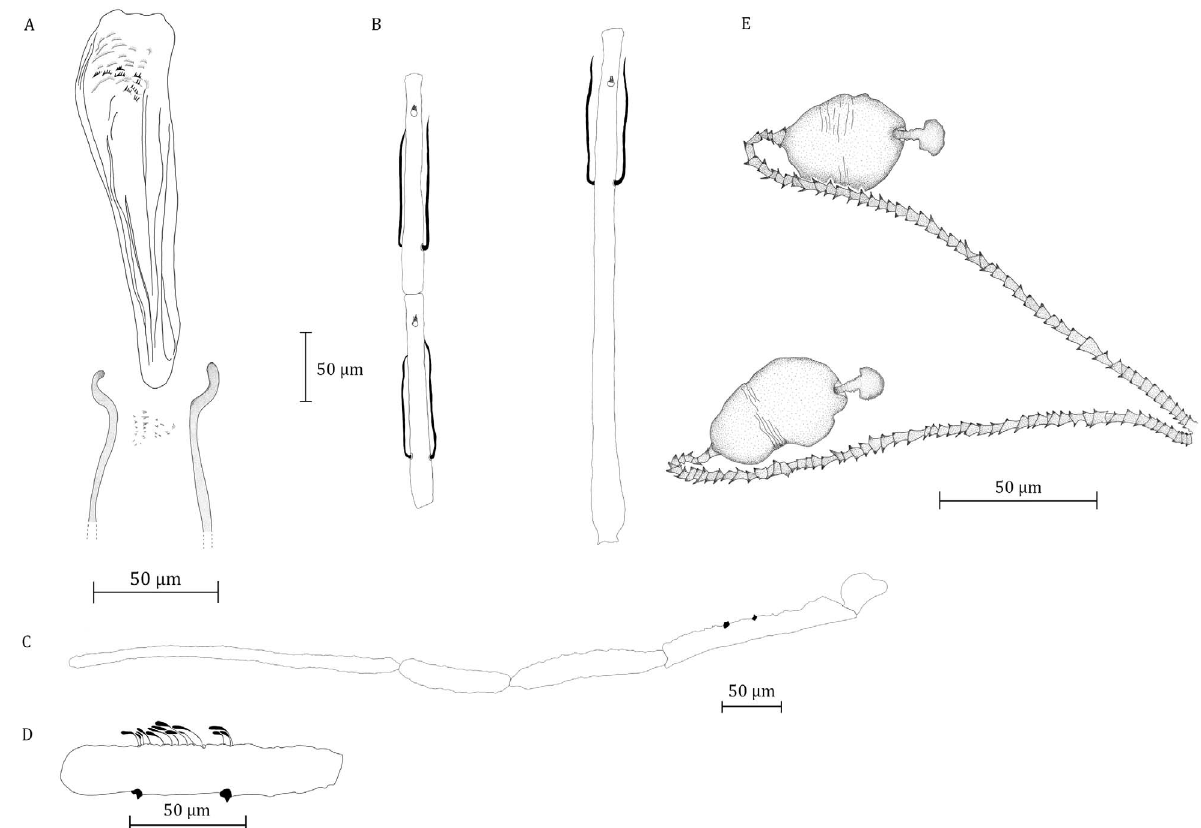
Figure 3. Ph. yunshengensis female. A: pharynx and cibarium; B: fl agellomeres 1, 2, and 3; C: palp; D: detail of 3rd palpal article; E: